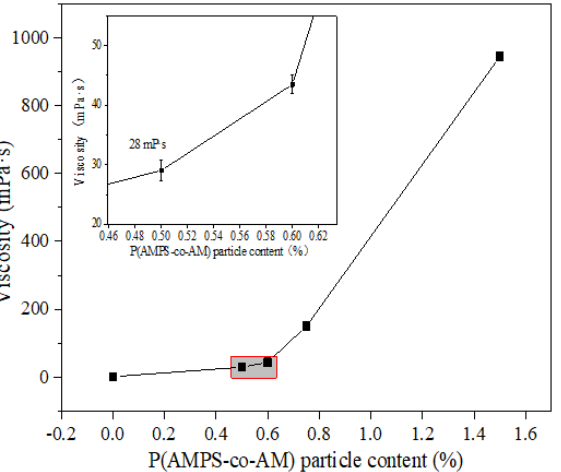
Figure 1. Effect of P(AMPS–co–AM) microgel content on the viscosity of prepolymerized liquid.